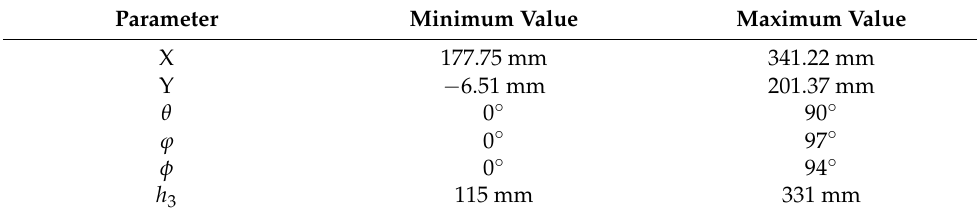
Figure 6. End-effector workspace. Table 3. The workspace parameters of the mechanism.